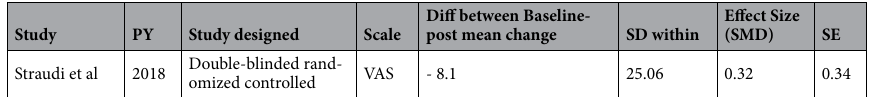
Table 13. Pain. Real Vs Sham. PY = Publication Year. SMD = Standardized Mean Difference. SE = Standard Error.